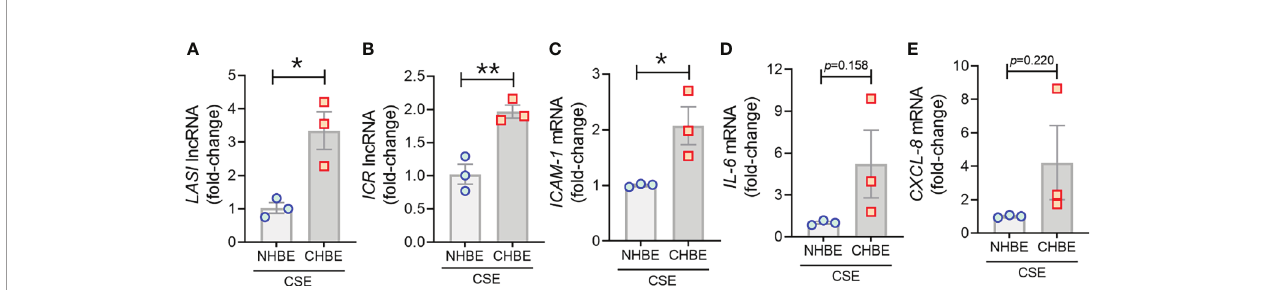
FIGURE 4 | Cigarette smoke exposure of COPD bronchial epithelial cells induces higher levels of immunomodulatory lncRNAs, and in fl ammatory factor mRNAs compared to non-COPD control cells. Primary NHBEs and CHBEs grown in submerged culture setting were treated with a 20 µg/ml cigarette smoke extract (CSE) and forty-eight hours after treatment cells were harvested and qRT-PCR was performed. Relative transcript levels for lncRNA LASI (A) , and ICR (B) in CSE-treated NHBE and CHBE cells as determined by qRT-PCR. Relative mRNA levels of ICAM-1 (C) , IL-6 (D) , and CXCL-8 (E) in fl ammatory factors. Data shown as mean ± SEM as fold-change over NHBEs; n=3/gp; data analyzed by student ’ s t-test; * p <0.05; ** p